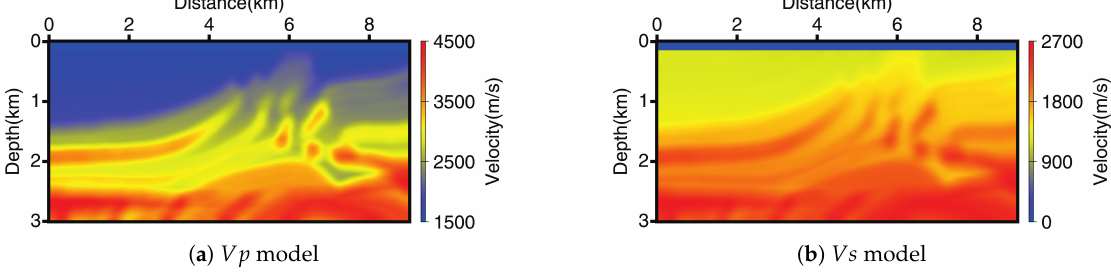
Figure 11. Initial models of Vp ( a ) and Vs ( b ).